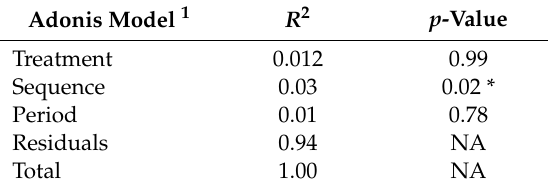
Table 5. PERMANOVA 1 analysis of di ff erent factors with the unweighted UniFrac distance matrix. Adonis Model 1 R